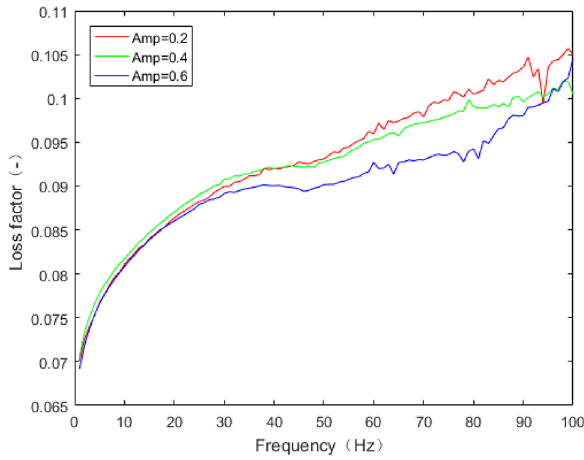
Figure 11. Relationship between radial loss factor and frequency in test.